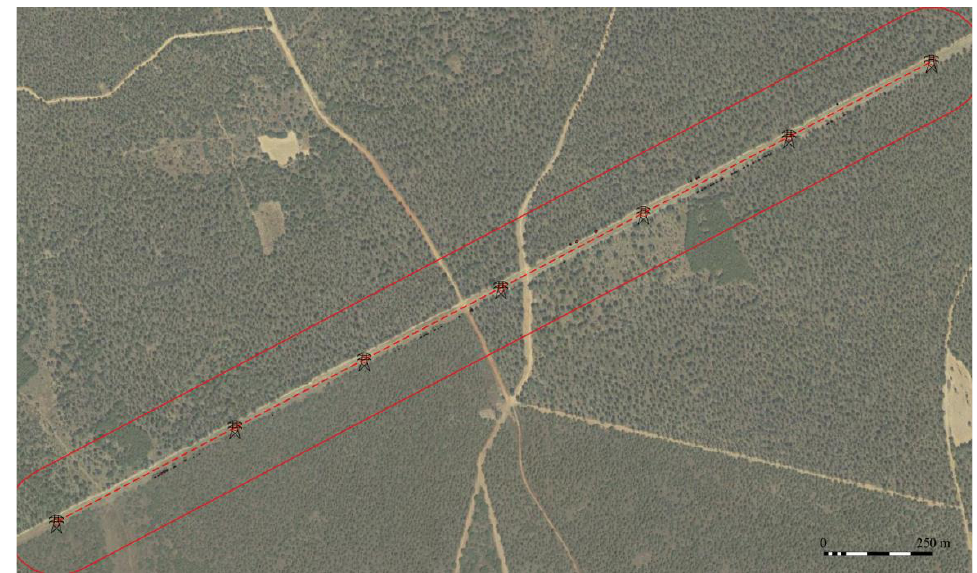
Figure 9. Risk areas obtained with drone LiDAR data using the theoretical catenary based on the maximum sag hypothesis.